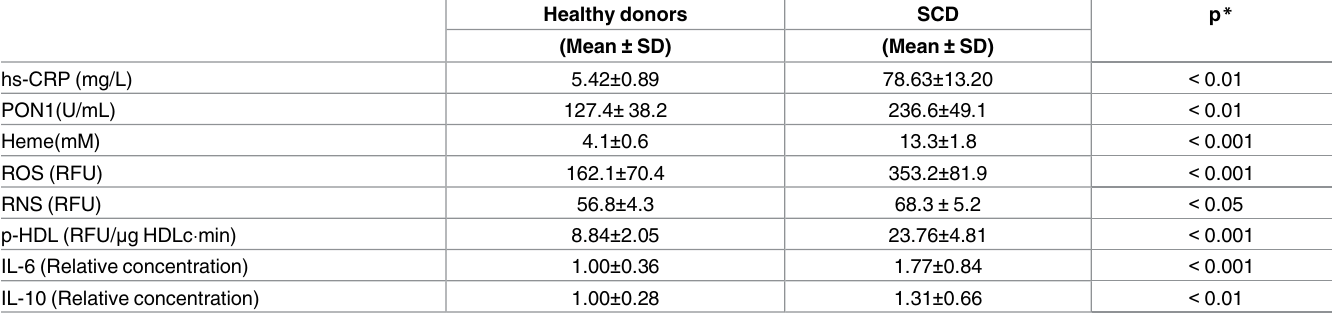
Table 2. Levels of inflammatory markersin plasma in 32 sickle cell disease (SCD) patients and 28 healthy normal